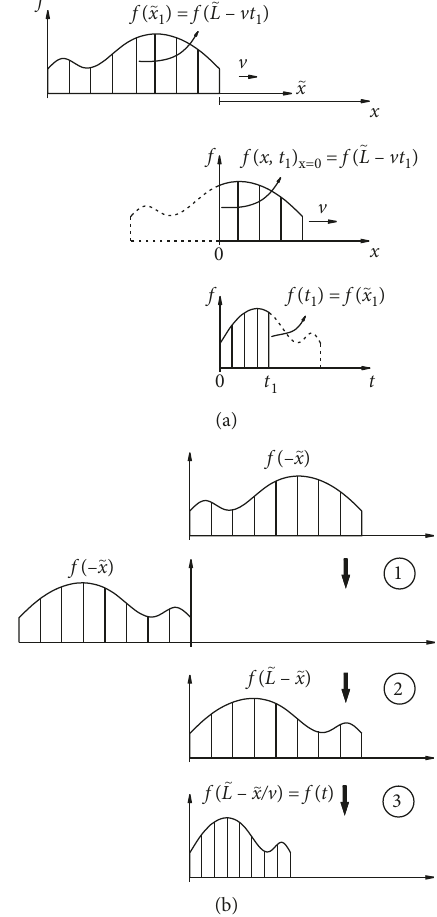
Figure 9: A distributed force moving at a constant speed of v . (a) Relationship between the pressure signal of a point and the dis- tributed force. (b) Procedure of changing from f